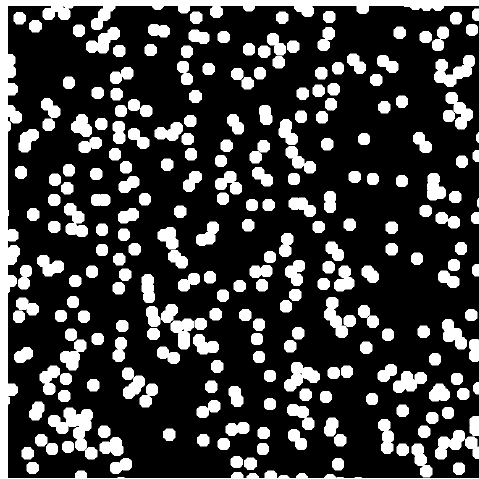
Figure 8. Simulated distribution pattern of black spruce (Neyman distribution, m 2 = 4, 1000 trees distributed in 4 ha). The white circles represent the nadir projection of the crowns to mark the tree positions, while the black represents the soil